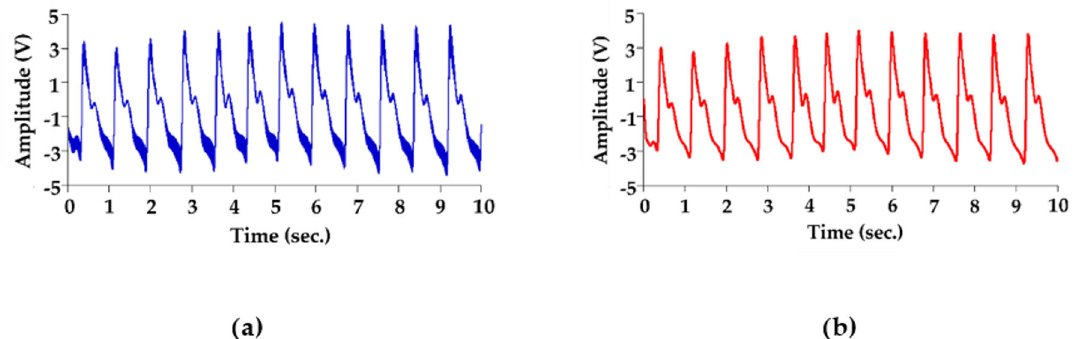
Figure 7. PPW signals from the ( a ) analog circuit ( b ) post-processing unit.